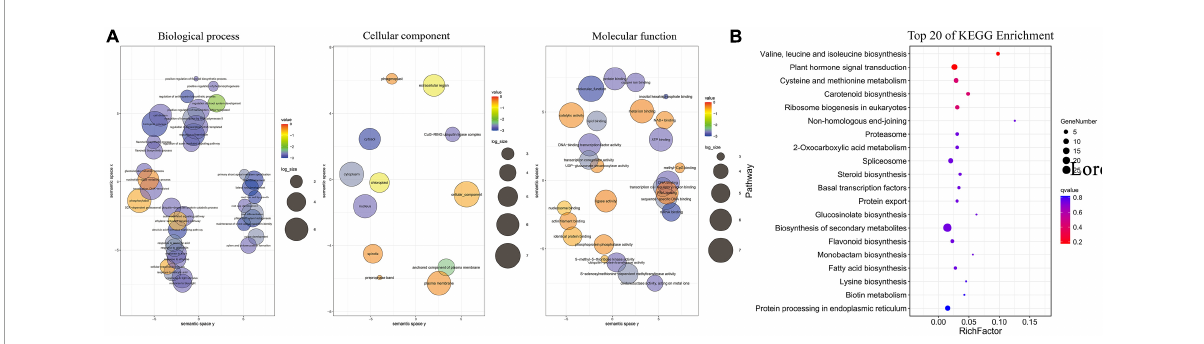
FIGURE4 Gene ontology (GO) and Kyoto Encyclopedia of Genes and Genomes (KEGG) functional classification of identified target genes. (A) GO enrichment analysis for targets of DE miRNAs under conditions of phosphate (Pi) starvation. (B) KEGG Enrichment Analysis for Targets of DE miRNAs under conditions of Pi